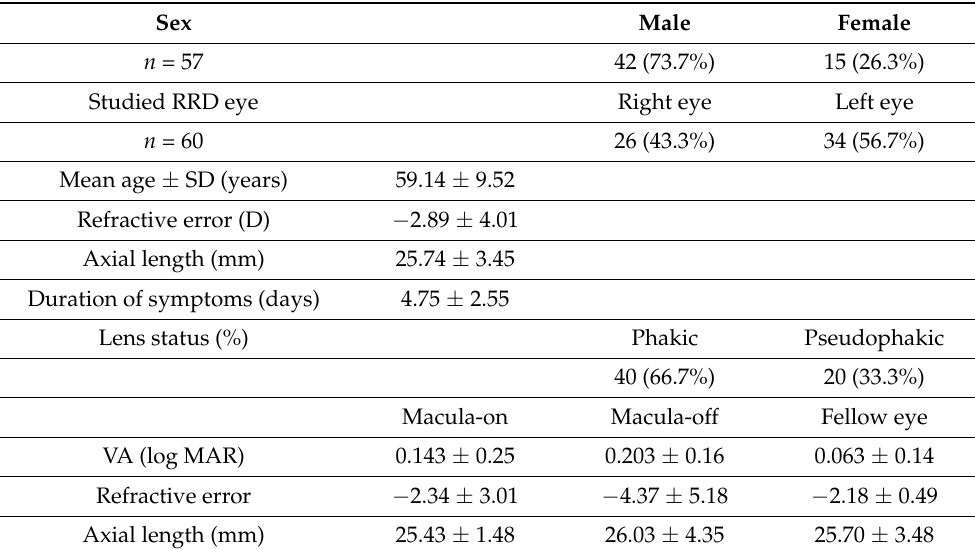
Table 1. Clinical and demographic characteristics of the RDD patients. Control group included the fellow healthy eye of the RRD eye.